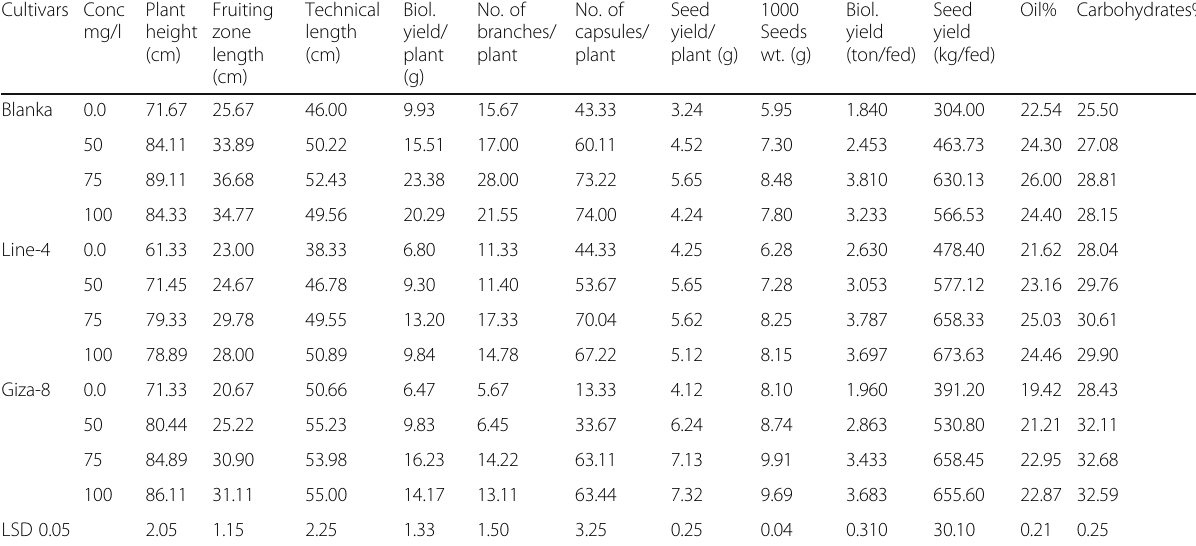
Table 16 Effect of cultivars and phenolic acid concentrations on seed yield and its components of flax plants grown under sandy soil conditions (data are means of two successive seasons) Cultivars Conc Plant mg/l height